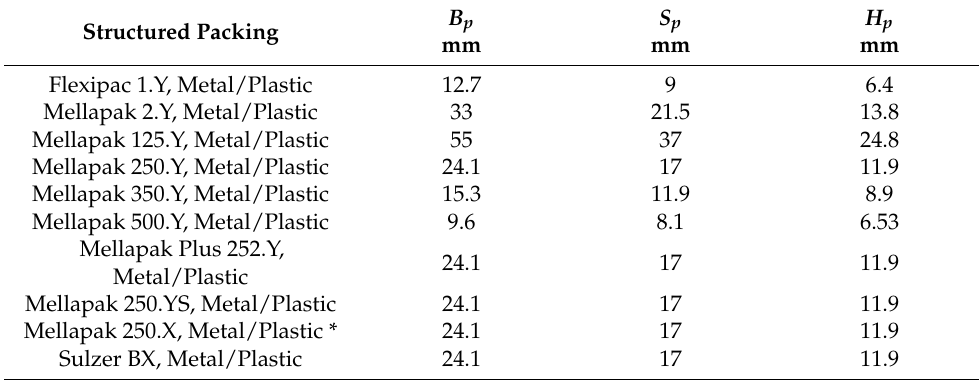
Table 2. Packing dimension parameters for different packing type [36]. * The data for Mellapak 250.X are available in Flagiello et al.